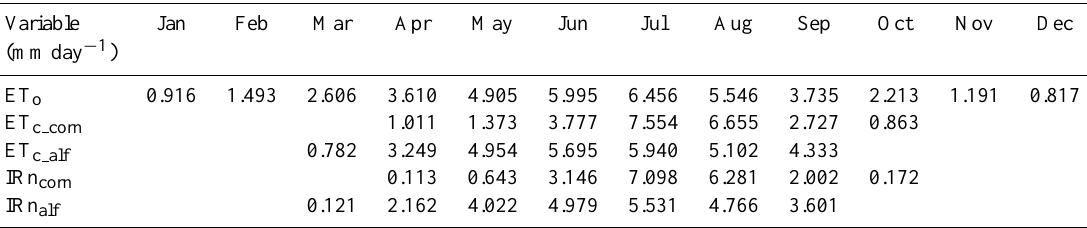
Table 8. Average monthly values for ET o , ET c corn , ET c alf , IRn corn and IRn alf (mmday − 1 ) during the period 2004–2011 for irrigation district of Riegos del Alto Arag´on (RAA, Gra˜n´en weather station).